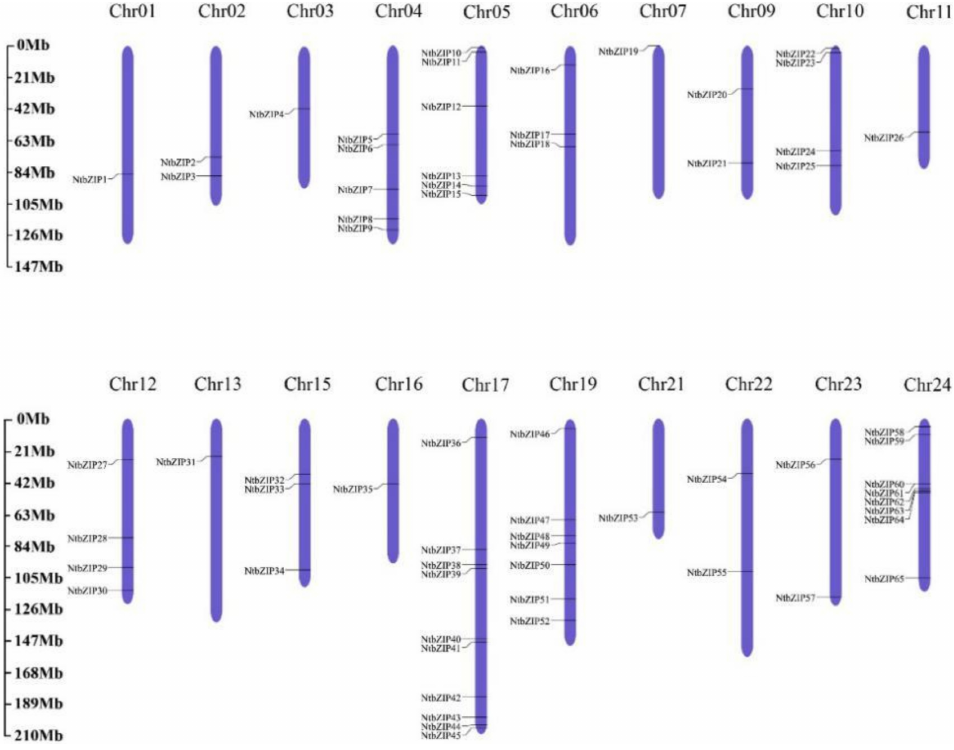
Figure 3. Distribution of 132 bZIP genes on the 20 chromosomes of tobacco. Segmental duplication events for the NtbZIP genes were detected using the MCScanX tool. A total of 15 tobacco bZIP segmental duplication pairs were identified (Figure 4). Notably, 18.2% of the identified tobacco bZIP genes may have arisen through segmental duplication events, which have played important roles in the expansion of tobacco bZIP gene family. Ka/Ks is the ratio between non-synonymous and synonymous substitutions, which can be used to estimate purifying selection, neutral mutations, and beneficial mu- tations. The Ka/Ks ratios of 15 tobacco bZIP duplication gene pairs were calculated; the Ka/Ks ratios of the tested pairs were less than 1, suggesting that these bZIP genes may have undergone purifying selective pressure. The details of the segmental duplication genes are provided in Supplementary Table